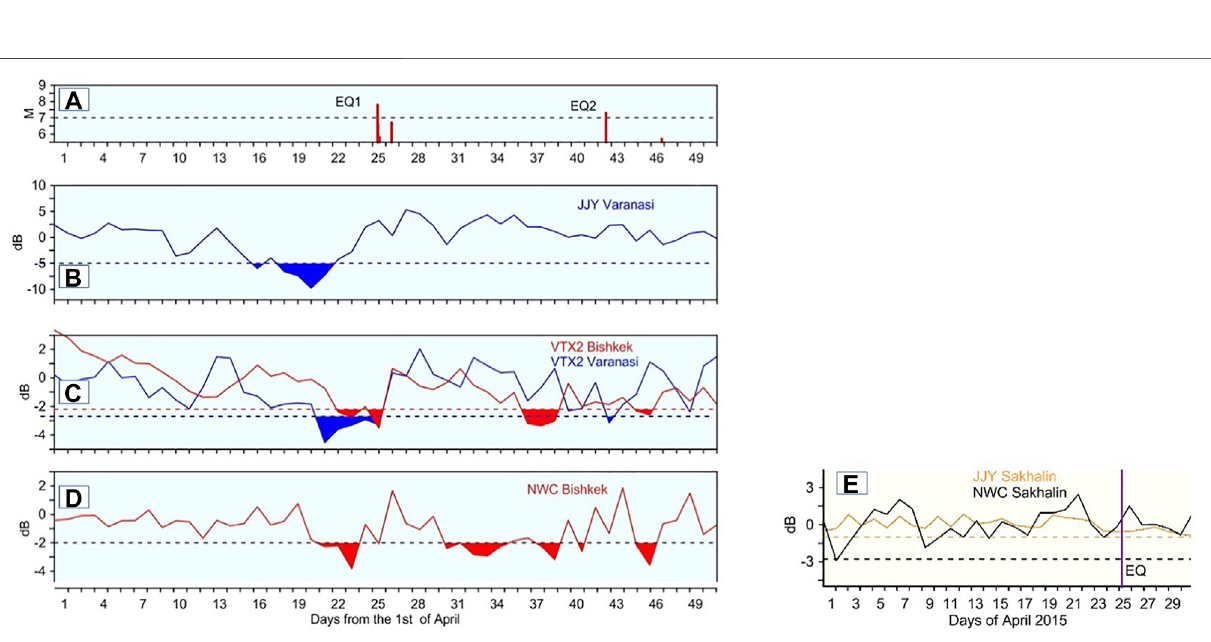
FIGURE 12 | (A – D) The results of the VLF/LF analysis. The average residual amplitudes of the VLF/LF signals in the nighttime are shown (top to down) for vrx (17.0 kHz)transmitter recorded in Bishkek (red) and Varanasi (blue), NWC (19.8 kHz) transmitter recorded in Bishkek, JN (40 kHz) transmitter recorded in Varanasi. The bottom panel shows JJY (yellow) and NWC (black) transmitter signals recorded in Yuzhno-Sakhalinsk stations (control “ aseismic ” paths). The upper panel shows the occurrence time of the earthquakes. The color- fi lled zones indicate values exceeding the − 2a (a is the standard deviation) lEvel, indicated by the horizontal dotted lines. Fl the controlled pa1hs NWS Sakhalin and JJY